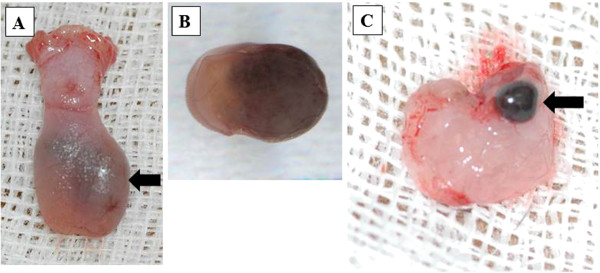
Gross findings of tongue and sentinel lymph node on day 5 in the spontaneous lymph node metastasis model of mice. (A) Blackish swelling (arrow) in the left side of tongue. (B) Cut surface of tongue showing a relatively circumscribed, blackish tumor. (C) Metastasis in sentinel lymph node (arrow).